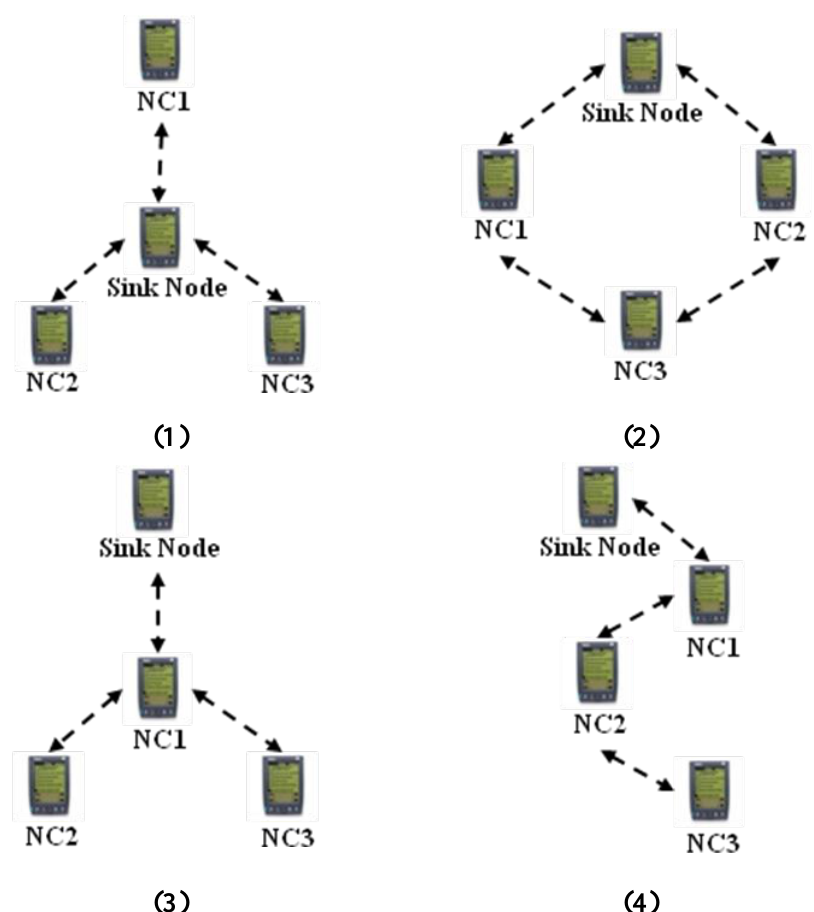
Figure 3. Topologies of the